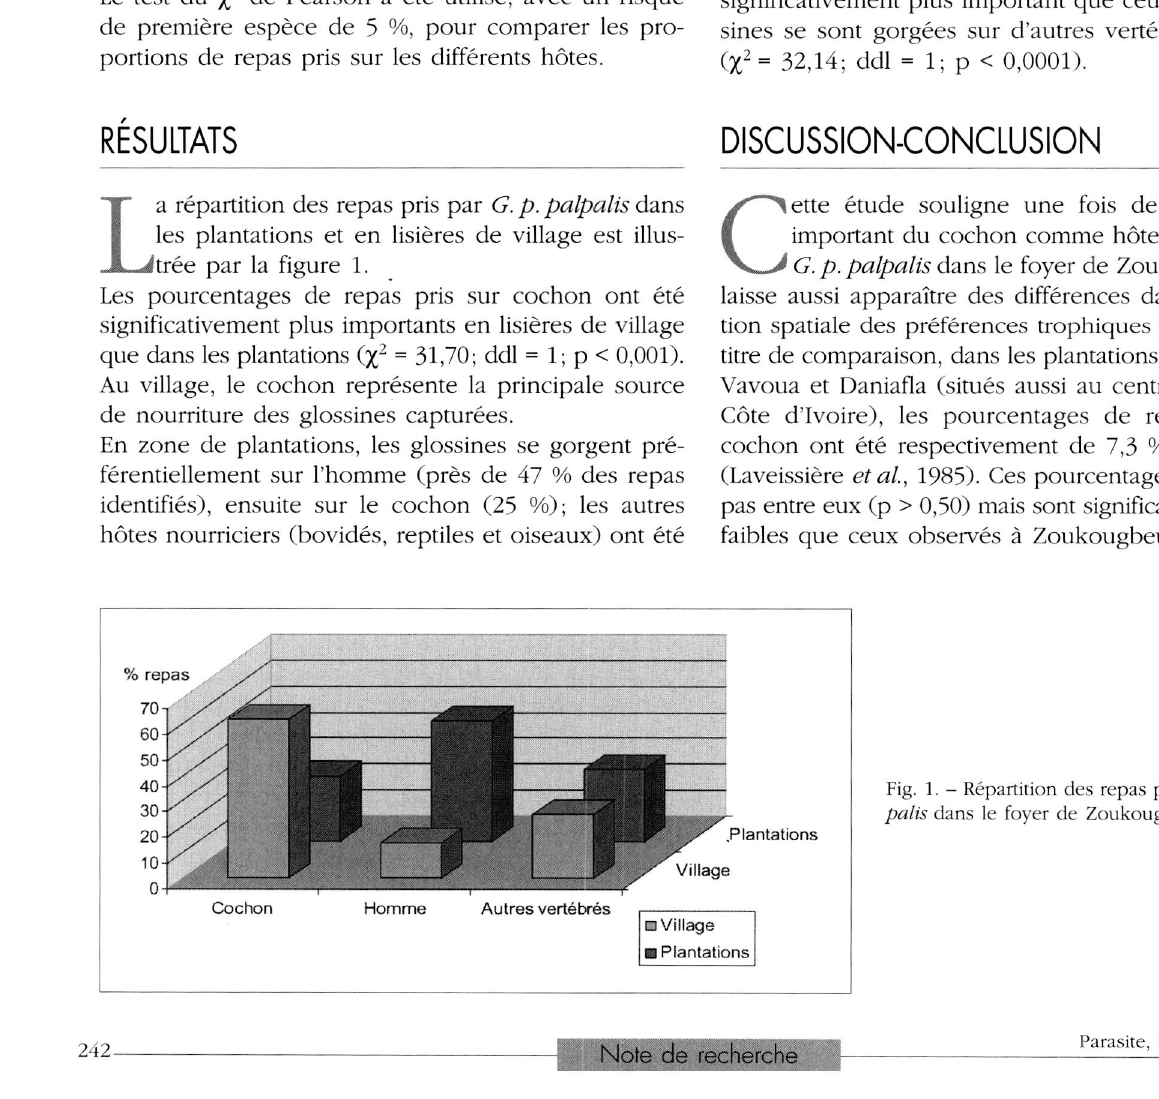
dans l'ensemble peu sollicités (28,1 % ). Dans cette